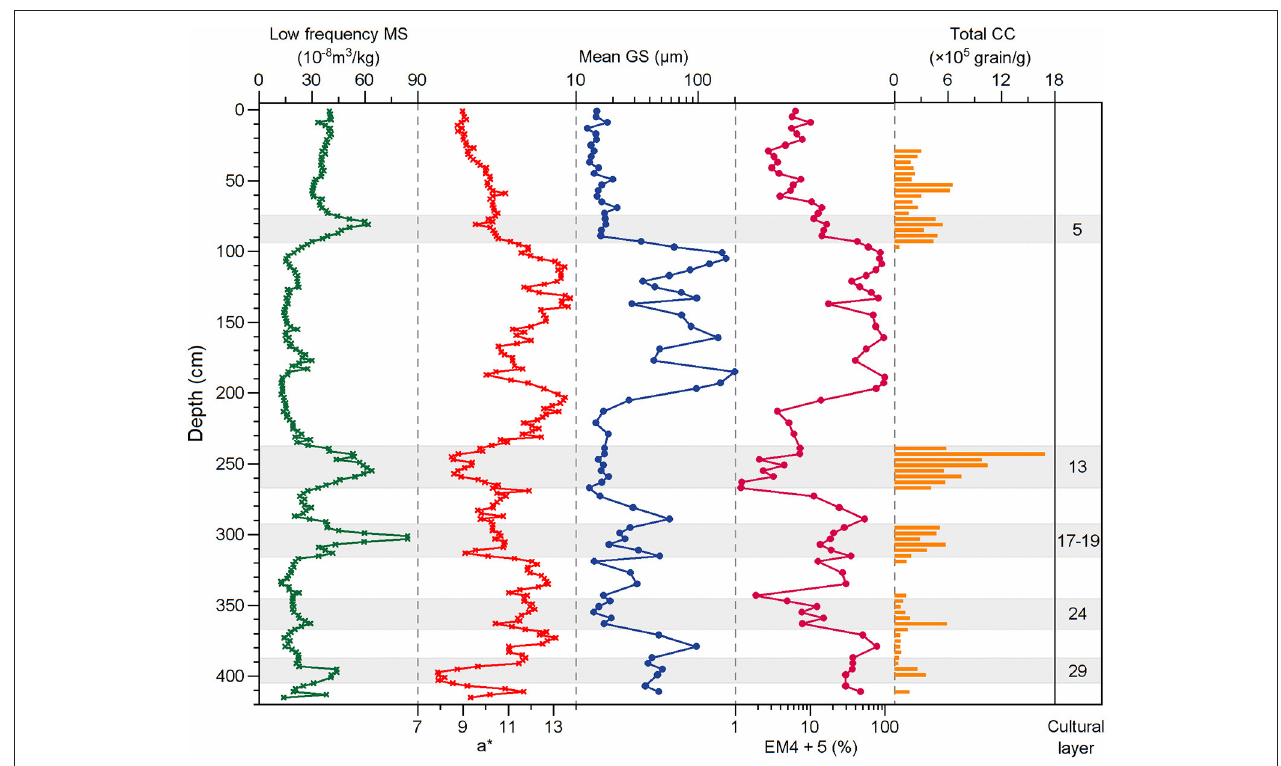
FIGURE 6 | Variations in environmental proxies in section T1406E. Symbols and terms on the graphs are defined as: MS, magnetic susceptibility; a*, redness; GS, grain size; EM, end-member; CC, charcoal